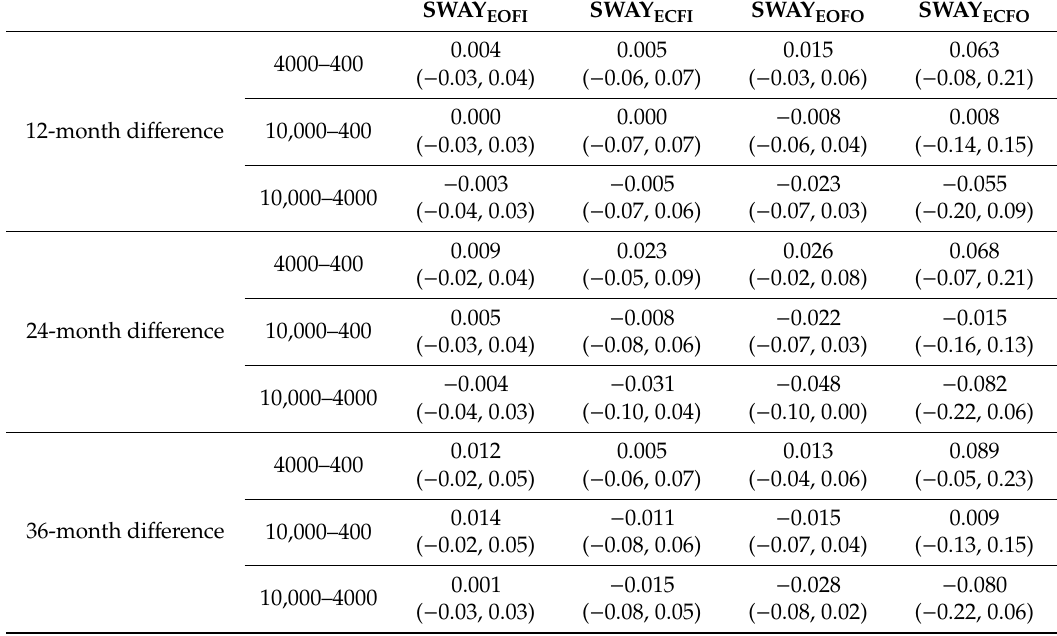
Table 3. Adjusted mean absolute di ff erence (95% confidence interval) in sway indices between treatment groups using linear mixed e ff ects